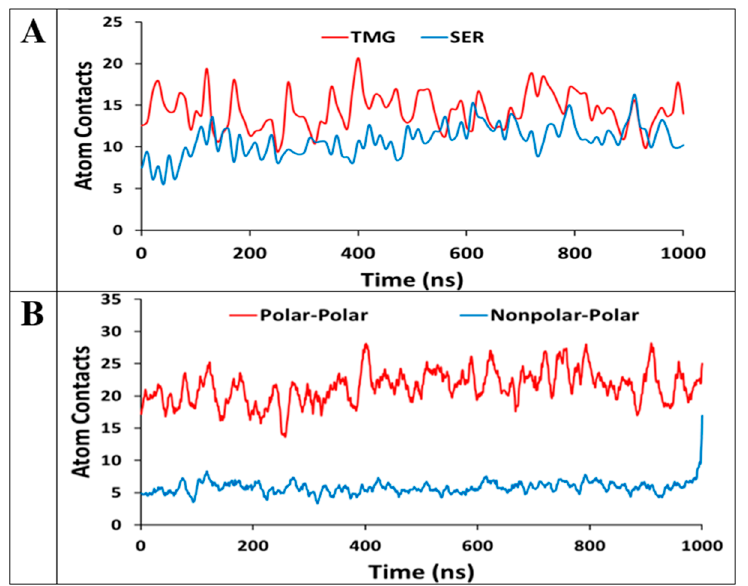
Figure 8. Average atom contacts between laccase protein and TMG-Ser over three 1000 ns trajectories. ( A ) Interactions of laccase protein with TMG (red) and Ser (blue). ( B ) Interactions of polar protein (red) and hydrophobic protein (blue) with TMG-Ser.